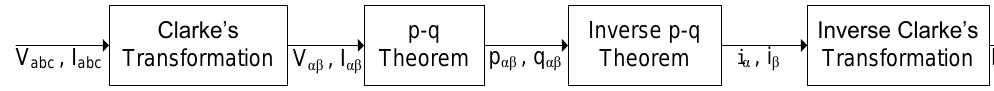
Figure 11. The basic concept modelling of a p-q theorem [125].